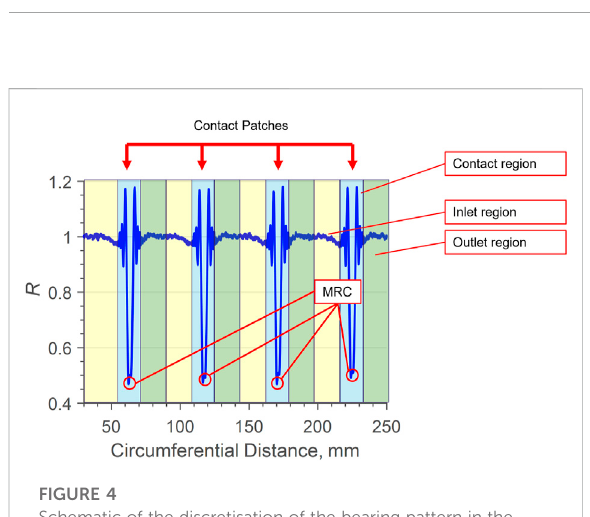
FIGURE 4 Schematic of the discretisation of the bearing pattern in the single frequency